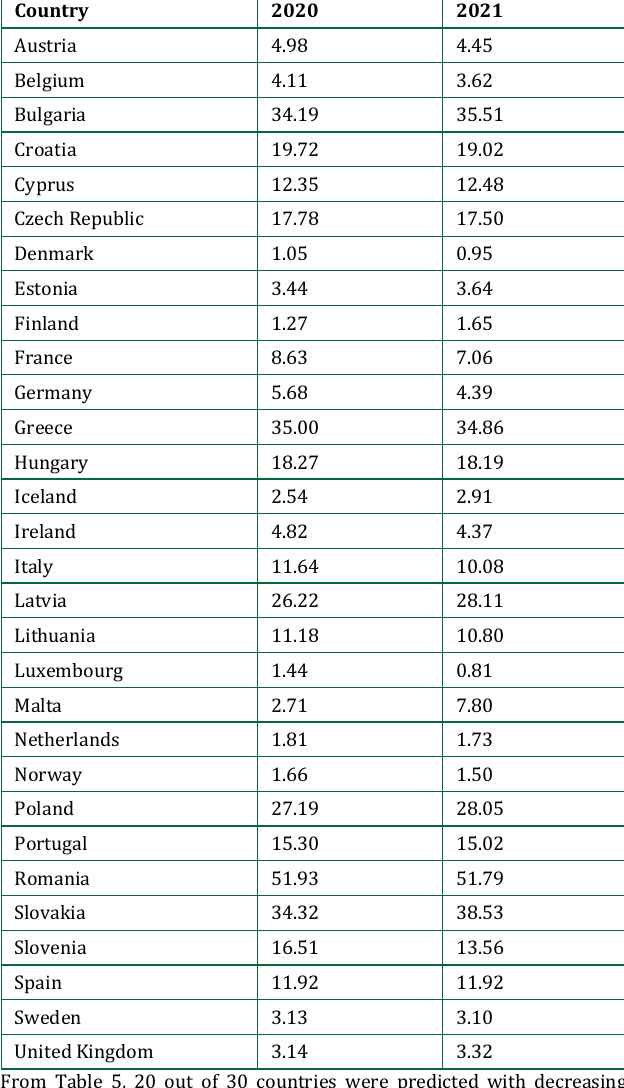
Table 5: Forecasted AMR’s percentage for Pseudomonas aeruginosa Country